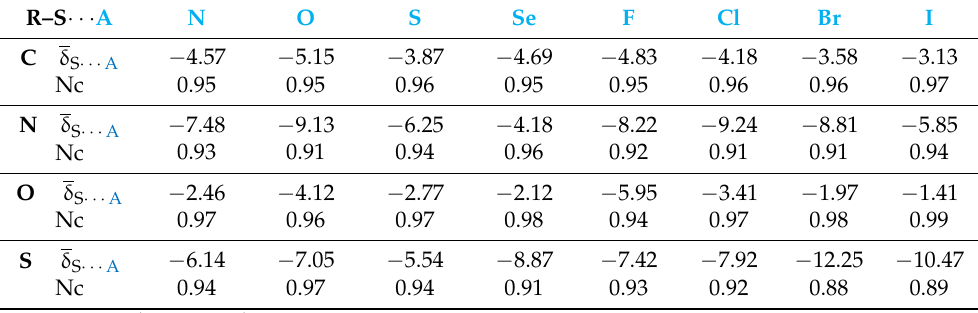
Table 1. Mean of δ S ··· Aa values ( δ S ··· A ) and normalized contact Nc b values calculated for the fragments R–S · · · A. R = C, N, O, and S; A = N, O, S, Se, F, Cl, Br, and